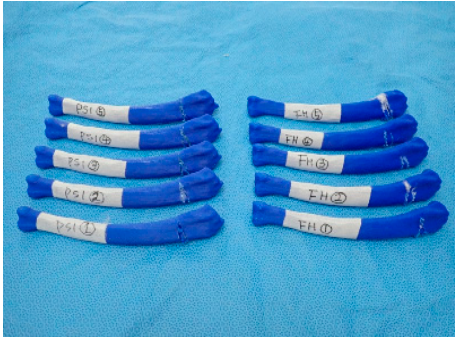
Figure 10. Simulative osteotomy result on phantom bone models. Patient ‐ specific instrumentation (PSI) and freehand (FH) marked rapid prototyping bone models are the result of the osteotomy using the PSI and freehand, respectively. This picture was taken after the ex ‐ vivo osteotomies were performed on the phantom bone models and the outer materials were removed. Table 1. Distance (mm) from the target plane to the cut plane: freehand (FH) vs. patient-specific instrumentations (PSI)